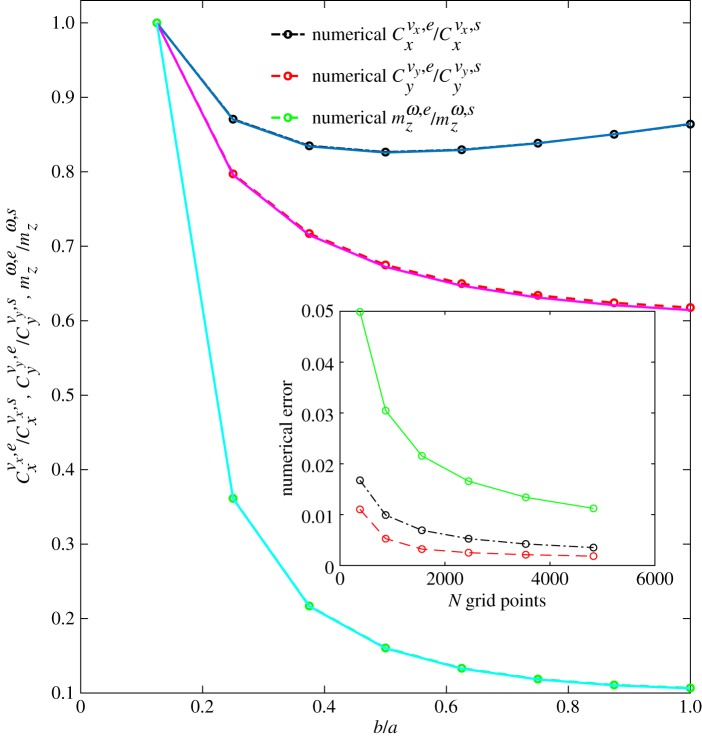
Ratio between Cxvx for a prolate ellipsoid, namely Cxvx,e, and Cxvx for a sphere of equal volume, namely Cxvx,s (black dashed-dotted line with circles and solid blue line), similarly, the ratio Cyvy,e/Cyvy,s (red dashed line with circles and magenta solid line) and mzω,e/mzω,s (green dashed line with circles and cyan solid line). The curves are rescaled by their maximum value to facilitate a direct comparison between them. The solid lines correspond to the analytical solution of equations (2.16)–(2.18), while the dashed lines with empty circles represent the numerical solution for an ellipsoid discretized by 4694 points. The inset shows the numerical error for these same quantities as specified by equation (2.19) and as a function of the number of points the surface is discretized into.